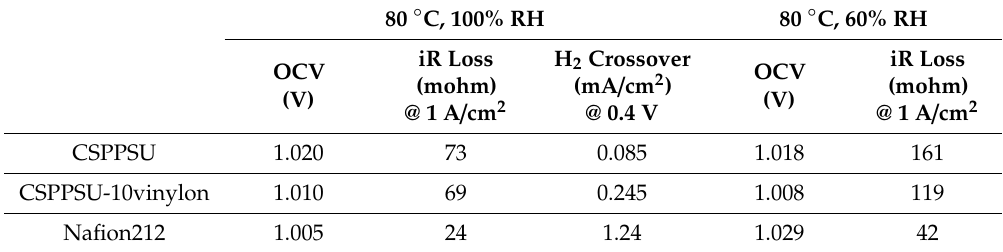
Figure 6. Current-voltage (I-V) properties of CSPPSU-10vinylon, CSPPSU, and Nafion212 membranes: ( a ) I-V iR free at 80 °C, 100% RH and ( b ) I-V iR free at 80 °C, 60% RH. Table 6. I-V and H 2 crossover data for single cells using the CSPPSU-10vinylon, CSPPSU, and Nafion212